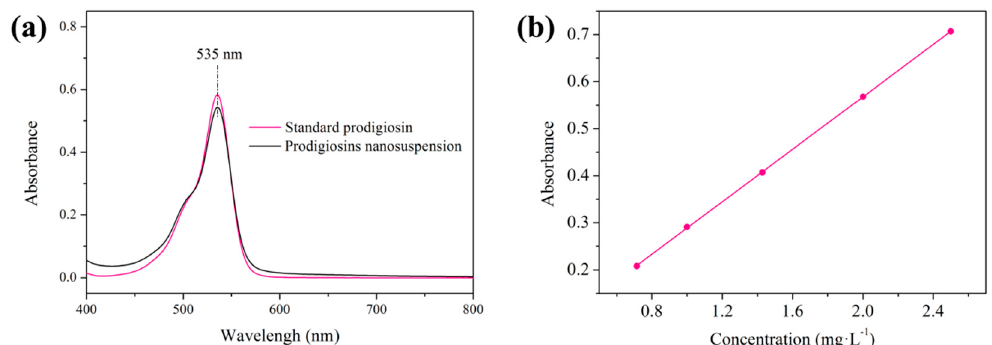
Figure 5. ( a ) Visible spectrum of standard prodigiosin and prodigiosins nanosuspension. ( b ) The fitting straight line of concentration/absorbance of standard prodigiosin solution.